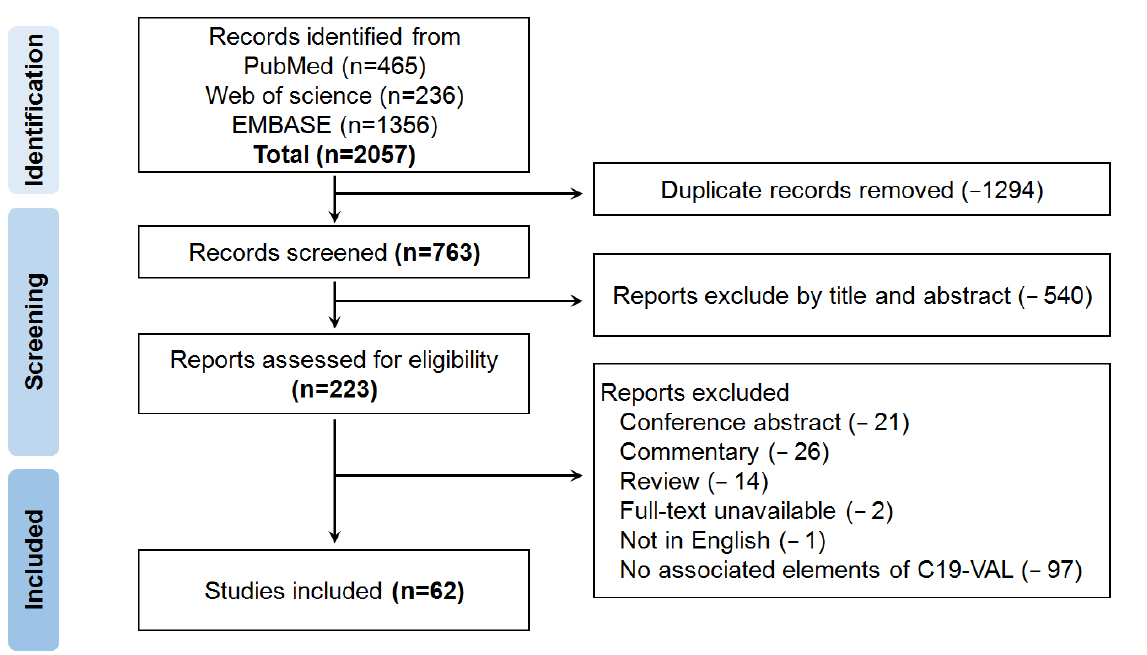
Figure 1. Flow chart of the systematic literature search and screening for studies of C19-VAL.